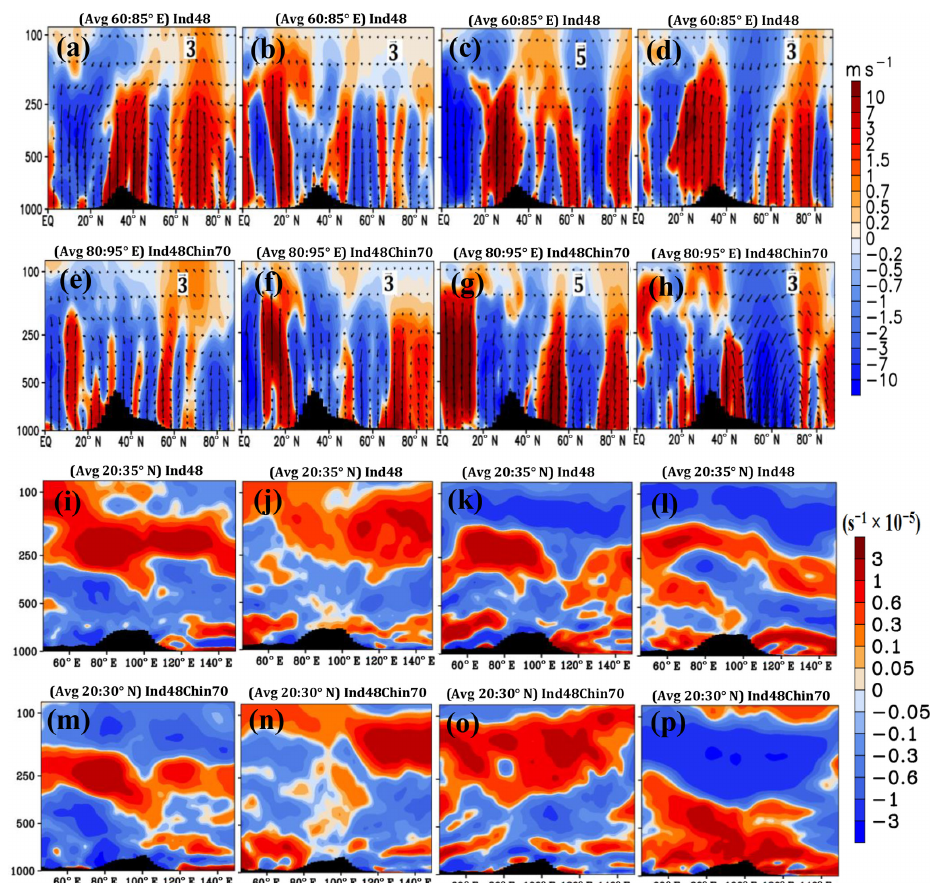
Figure 9. The distribution of anomalies in vertical velocity (ms − 1 ) from Ind48-CTRL for the (a) pre-monsoon, (b) summer-monsoon, (c) post-monsoon and (d) winter seasons; (e) – (h) same as (a) – (d) but for Ind48Chin70-CTRL simulations. Vertical velocity is scaled by 1000. Seasonal distribution of anomalies in the Brunt–Väisälä frequency (s − 1 × 10 − 5 ) from Ind48-CTRL for the (i) pre-monsoon, (j) summer- monsoon, (k) post-monsoon and (l) winter seasons; (m) – (p) same as (i) – (l) but from Ind48Chin70-CTRL simulations. For the vertical cross section, averages obtained over latitudes or longitudes are indicated in each panel. The black vertical bars indicate